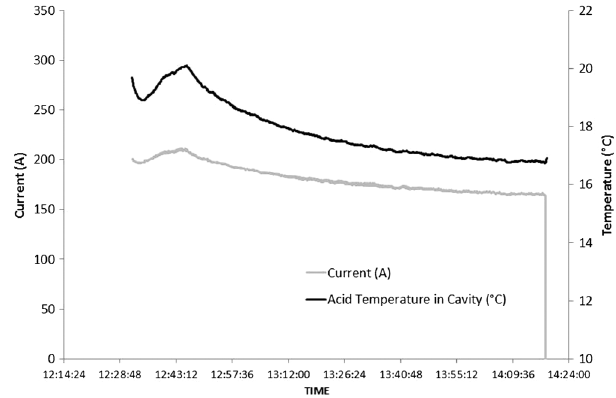
FIG. 13. Current and acid temperature as a function of time during VEP of a nine-cell Tesla-shape cavity.